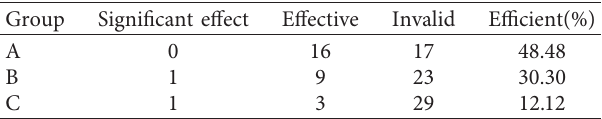
Figure 2: Comparison of GCSI scores. 3-0 and 7-0 are the scores obtained by the 3rd and 7th weekend scores minus the 0th week. Data were expressed as mean ± s ( n � 33). ∗ P < 0 . 05, compared with Zhongwan (CV 12) +Zusanli (ST 36) group; # P < 0 . 05, compared with Neiguan (PC 6)+Zusanli (ST 36) group; ΔΔ P < 0 . 01, com- pared with baseline period. Table 3: Overall efficacy evaluation of patients in each group after treatment (3rd weekend).